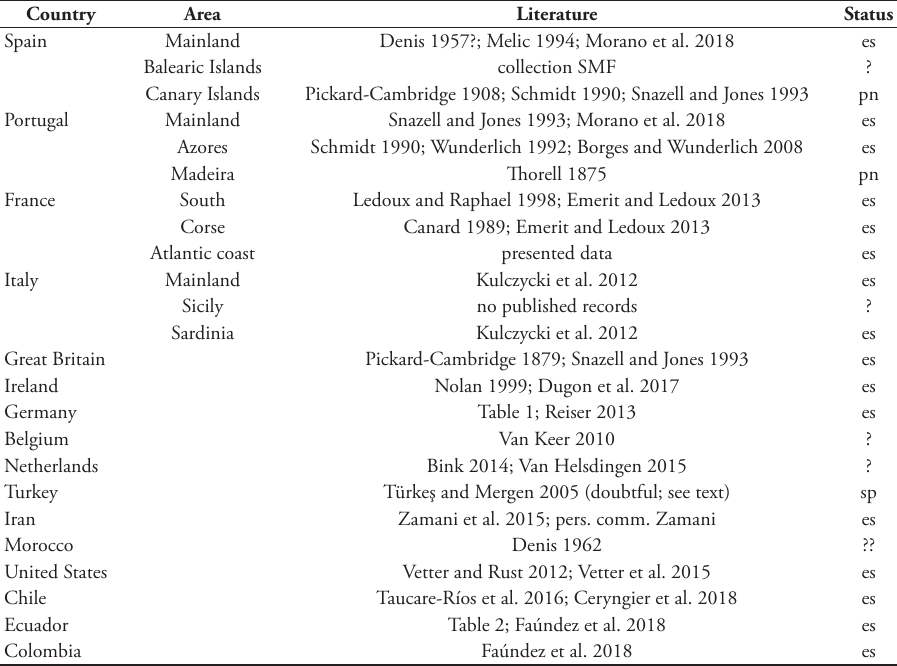
Table 3. Global distribution of Steatoda nobilis . es = established and non-indigenous, ? = unclear status, ?? = unverified mentioning, pn = probably native, sp = single specimen record.